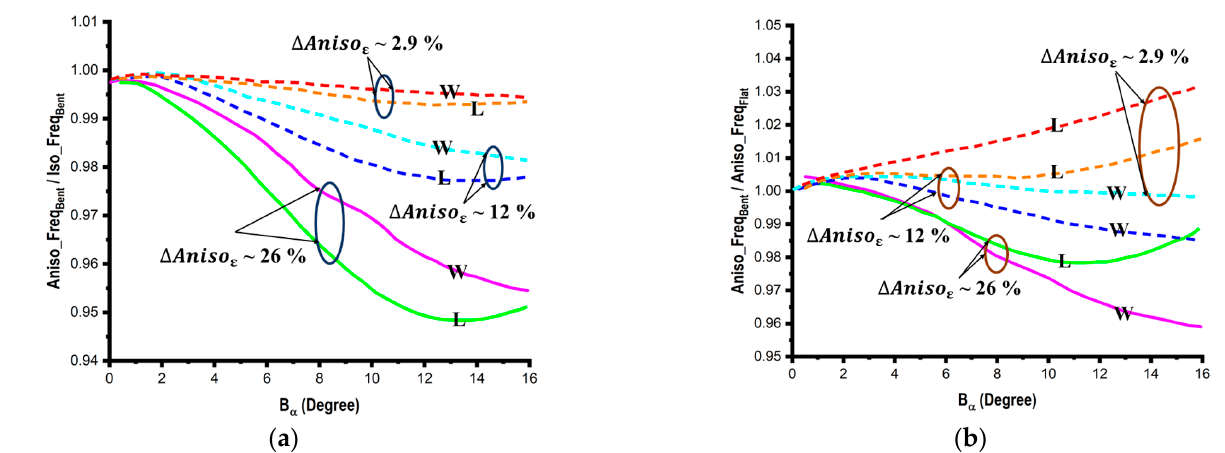
Figure 13. ( a ) Comparison of the e ff ect of bending on the resonant frequencies of the isotropic and anisotropic substrates and ( b ) concurrent e ff ects of bending and anisotropy.